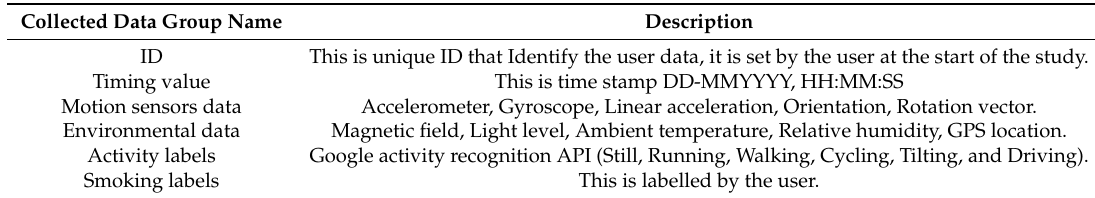
Table 1. The number of labels in each of the three labelling categories.